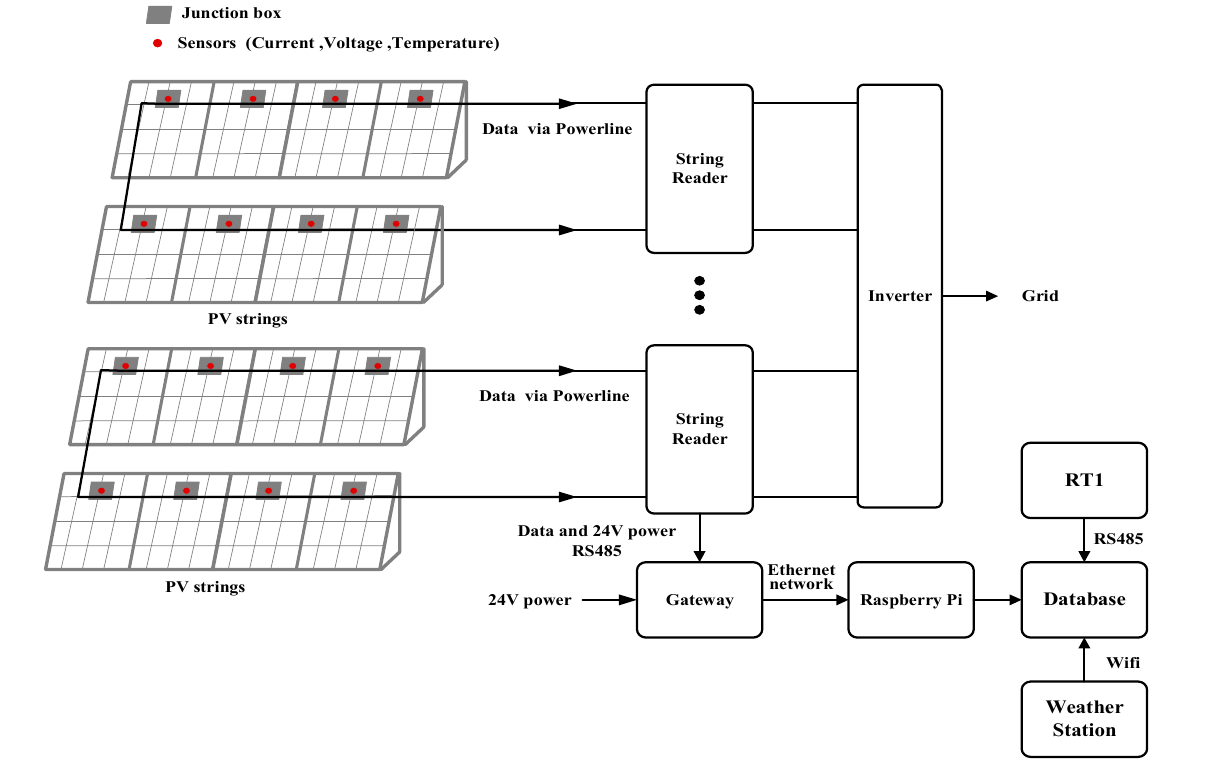
Figure 4. Data acquisition and transmission of a smart PV system.